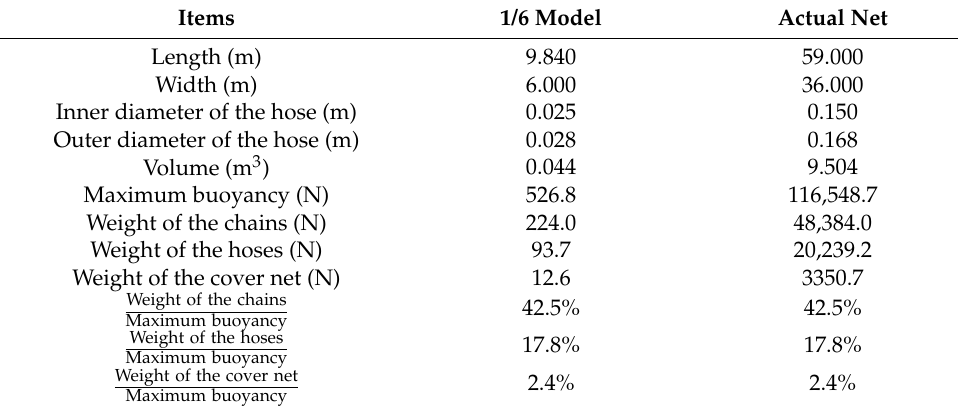
Table 1. Physical parameters of the model and actual hose